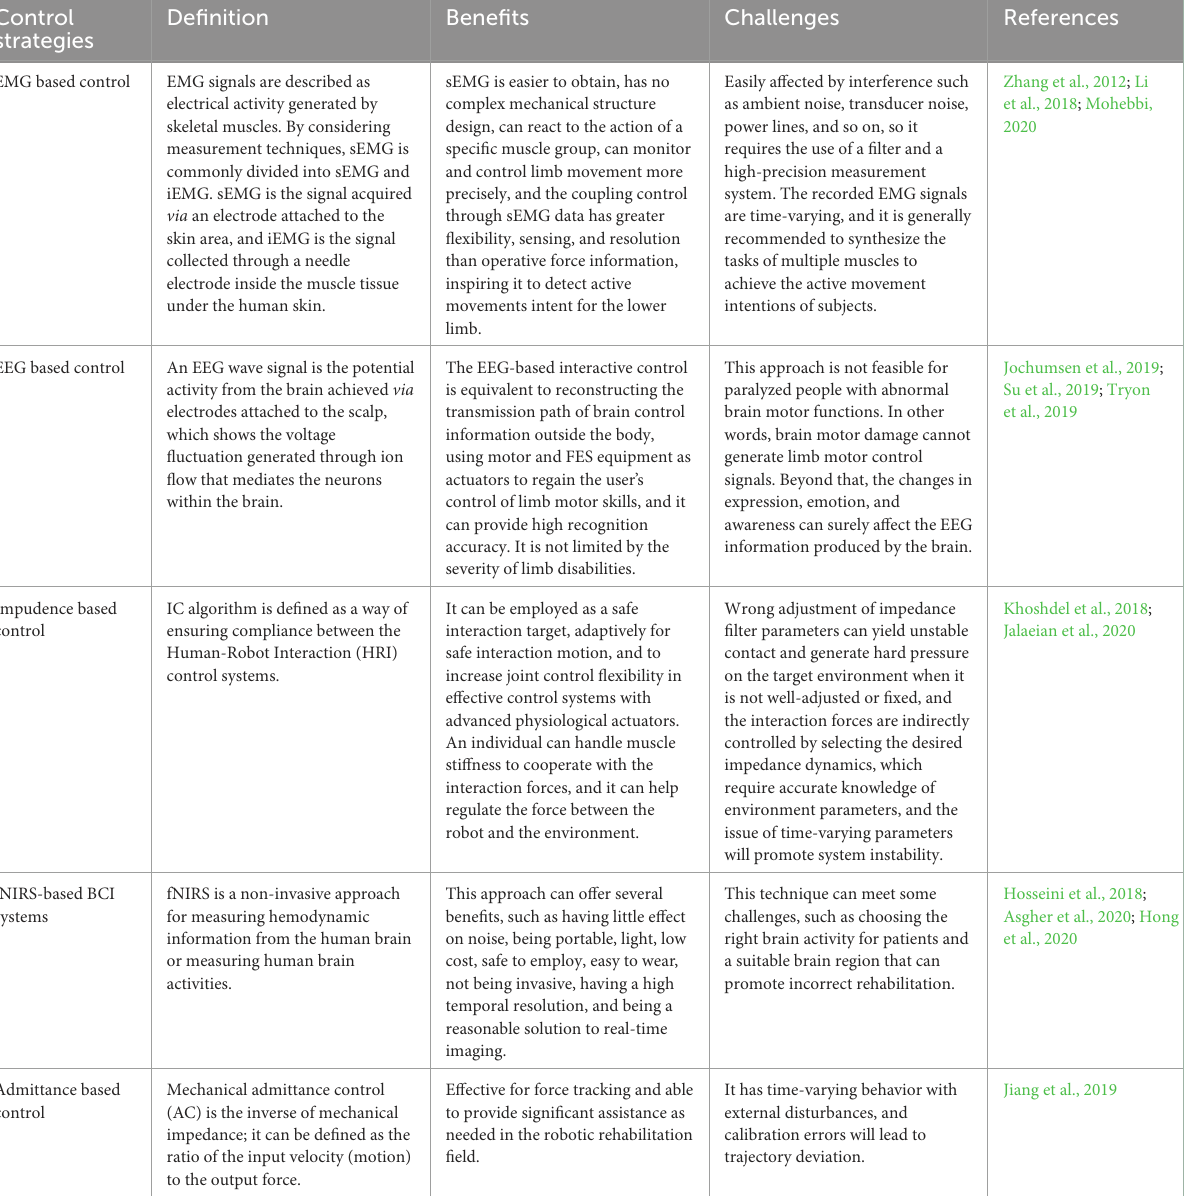
TABLE 4 Summary of HRCC to be